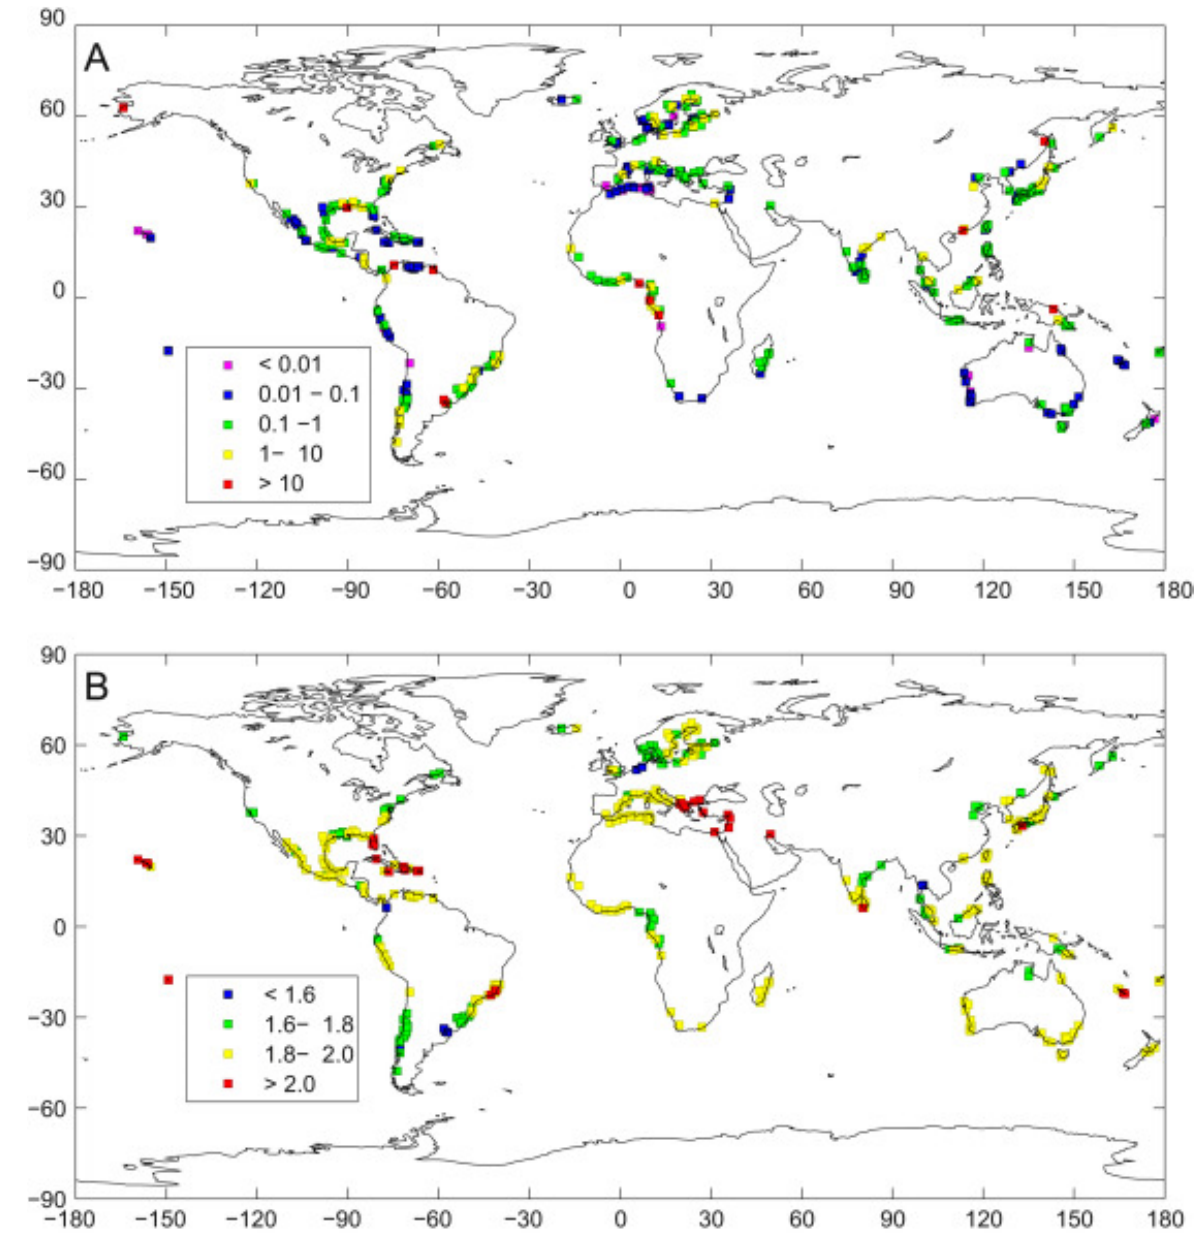
Figure 5. Average global sea surface salinity: ( A ) Energy that can be extracted (TWh/a) and ( B ) energy density (MJ/m 3 ) (adopted from [84] with license no. 5240621253046).